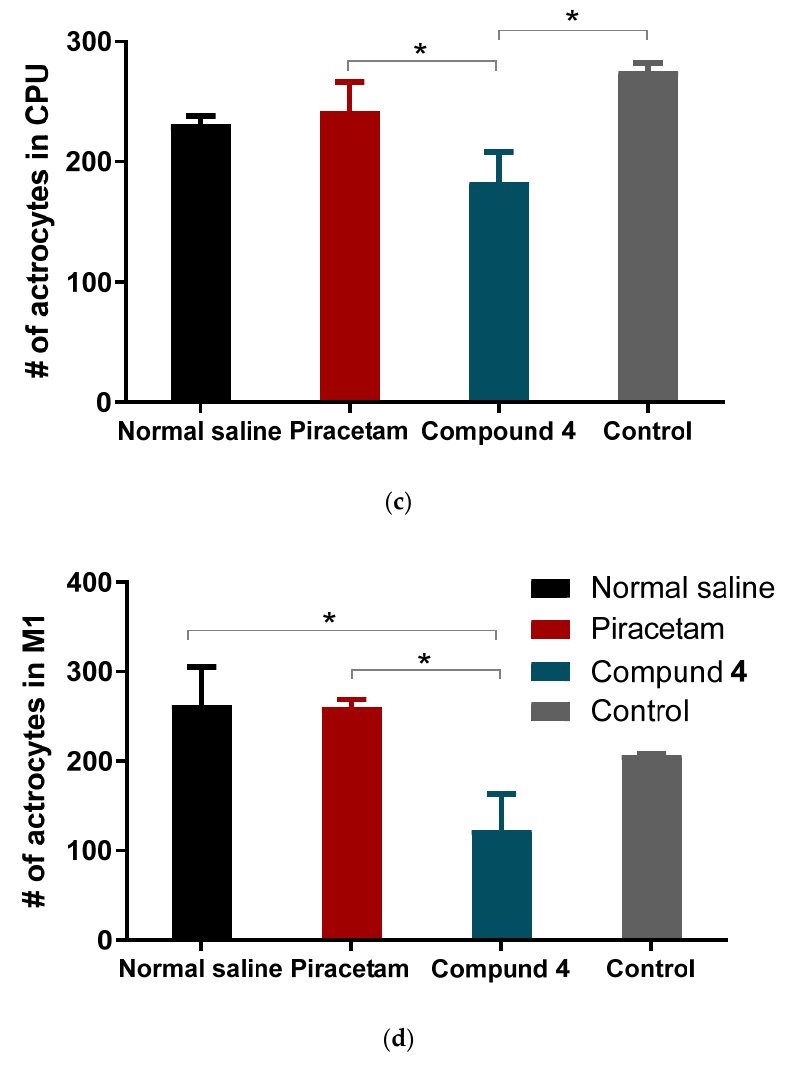
Figure 8. Areas for IHC Immunohistochemical imaging of astrocytes. Astrocytes are highlighted in blue. The number of cells was counted based on the automatic pipeline. ( a ) Examples of CPu area, ( b ) example of M1 area, ( c ) mean number of astrocytes per different treatment in CPu area ( d ). Mean number of astrocytes per different treatment in the M1 area. Data are presented as mean and SD. Normal saline—black, piracetam—red, Compound 4 —green, control—grey. * p < 0.05.